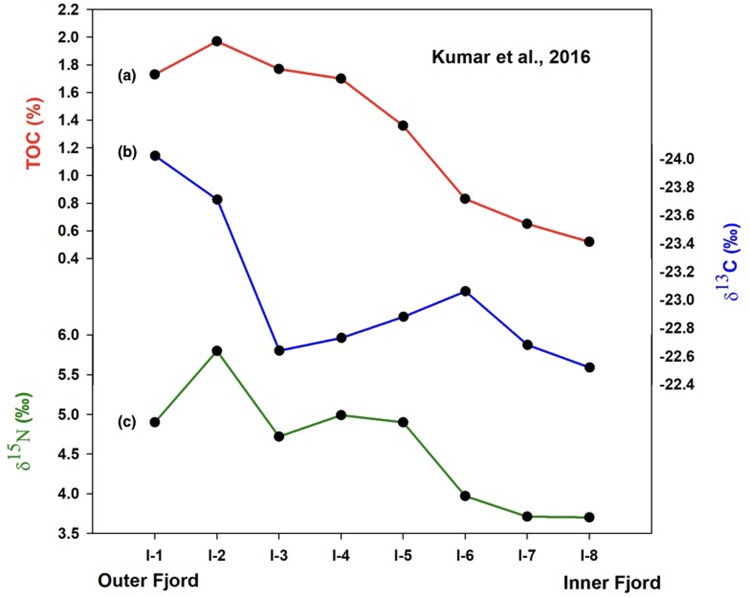
Spatial variability of (a) TOC, (b) δ13C and (c) δ15N along the fjord axis at Kongsfjorden (surface sediment data taken from [39]).